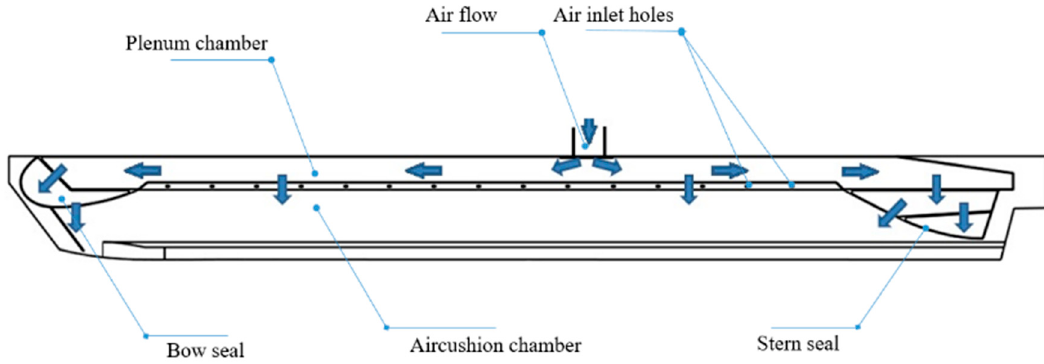
Figure 5. Internal flow passage of the PACSCAT hover system.